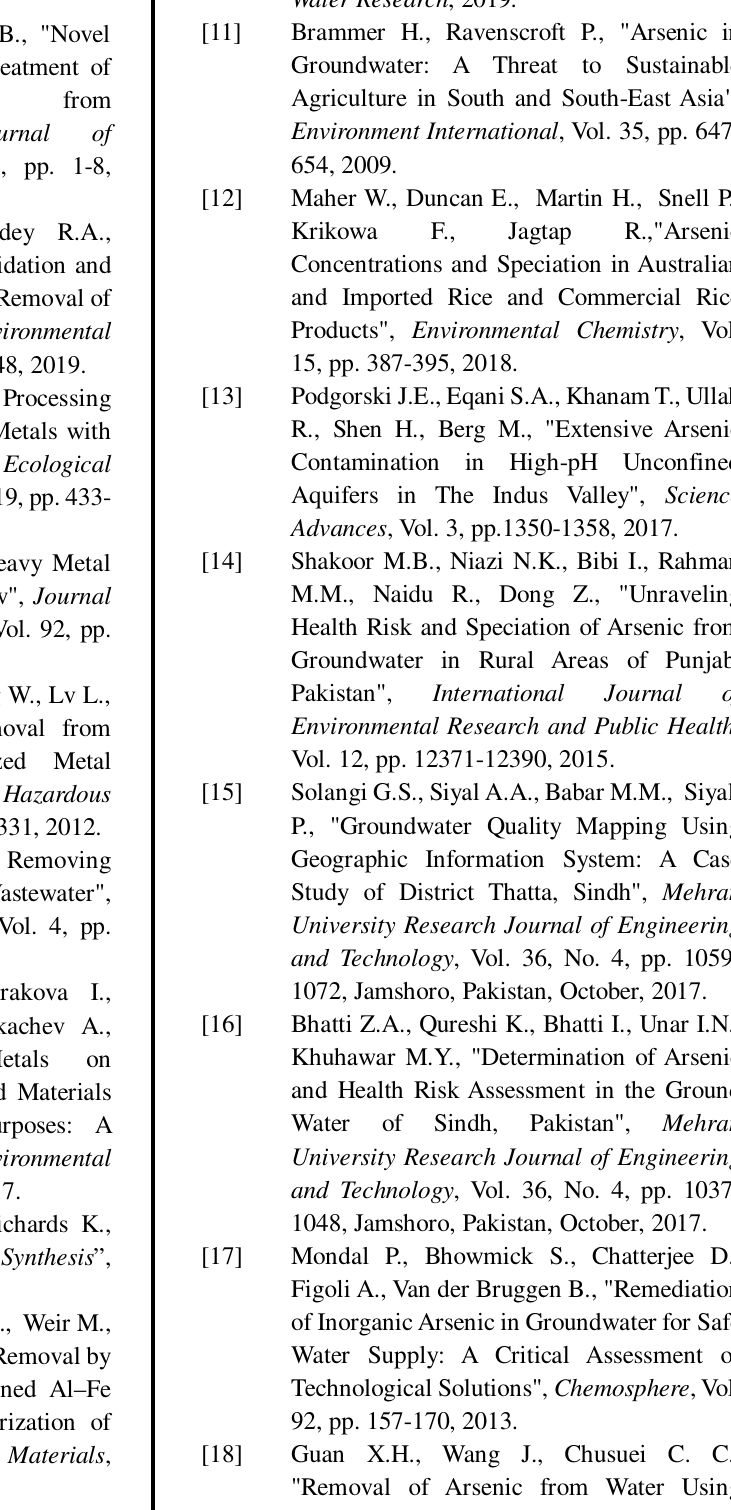
Figoli A., Van der Bruggen B., "Remediation of Inorganic Arsenic in Groundwater for Safe Water Supply: A Critical Assessment of Technological Solutions", Chemosphere ,